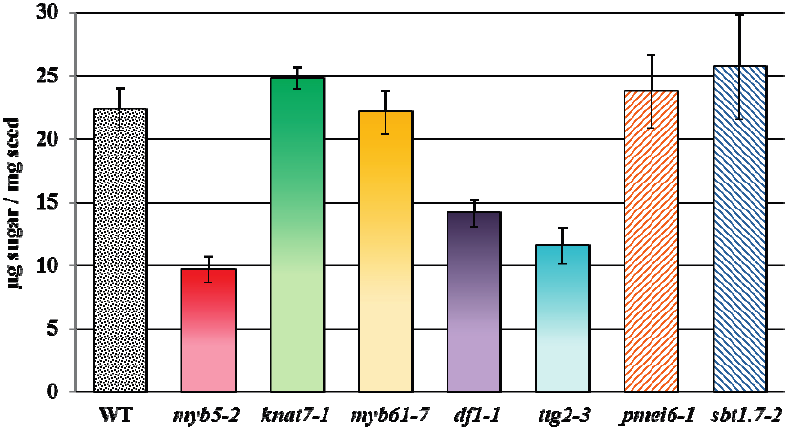
Figure 5. Total mucilage monosaccharides extracted from WT and several mutants. Values represent the mean ± SD of three biological replicates for each mutant and six for the WT. Total mucilage was extracted by vigorously shaking 5 mg seeds in 1 mL water using a Retsch Mill (30 Hz for 30 min). Monosaccharides obtained by trifluoroacetic acid hydrolysis were quantified using ion chromatography (see Supplemental Methods for a detailed